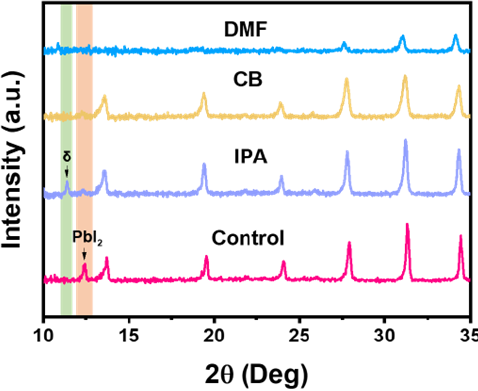
Figure 2. XRD results of perovskite films annealed under different solvent vapors.